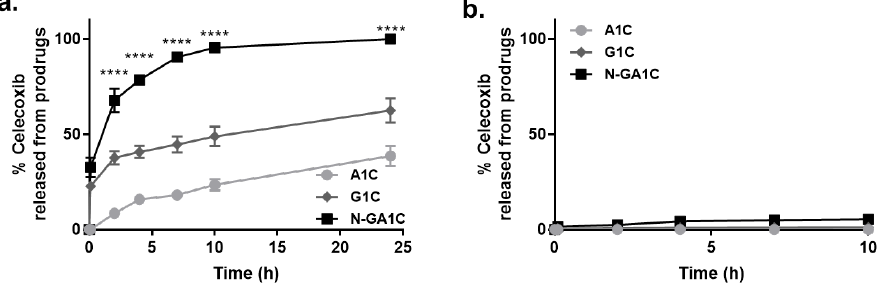
Figure 3. Celecoxib release profiles of A1C, G1C, and N-GA1C in liver homogenate and plasma. ( a , b ) Percentages of celecoxib released from the prodrugs after incubation with 20% suspension of liver homogenate ( a ) or blood plasma ( b ) in IPB. Data are presented as mean ± s.e.m. from a representative experiment ( n = 5) from 2 independent experiments. **** p < 0.0001, analyzed by two-way ANOVA with Tukey’s HSD multiple comparison post hoc test.